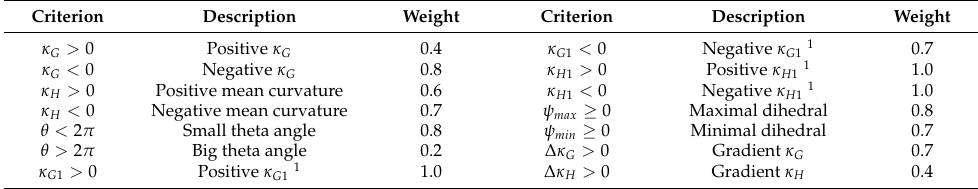
Table 1. Ordered statistic criteria ranking (Section 3.4 [27]).